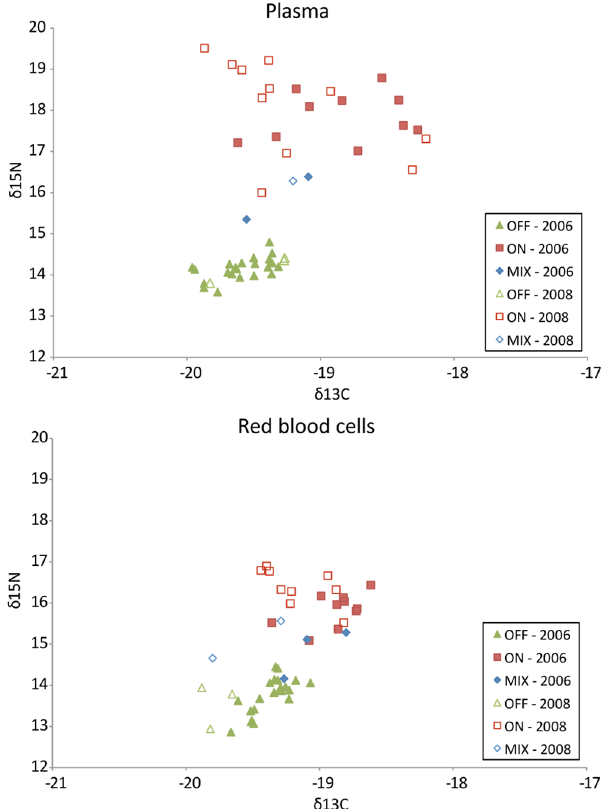
Fig 3. Individual δ 15 N and δ 13 C values for plasma and red blood cell tisues collected from adult female northern fur seals at Bogoslof and St. Paul Island rookeries during 2006 and 2008. On-shelf foragers (ON) exclusively utilized < 200m depth, off-shelf foragers (OFF) traveled beyond the 200m isobaths to forage and mixed-shelf foragers (MIX) made foraging trips to both on- and off-shelf habitat.